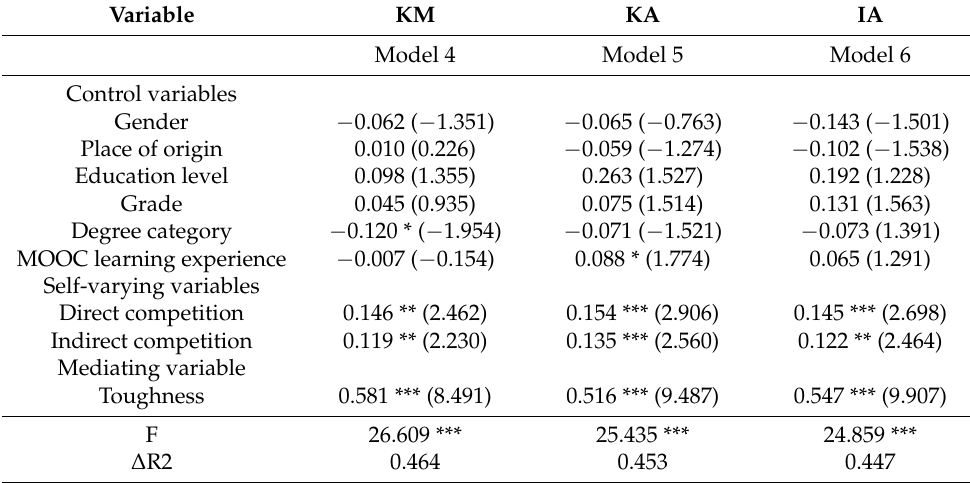
Table 3. Mediating effect of toughness.